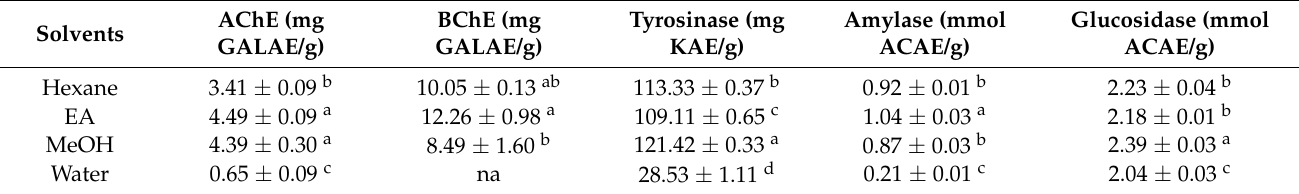
Table 4. Enzyme inhibitory effects of the tested